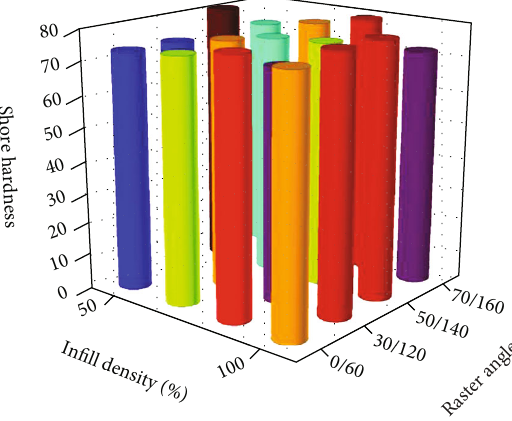
Figure 16: Shore hardness: 3D plot of in fi ll density and raster angle.